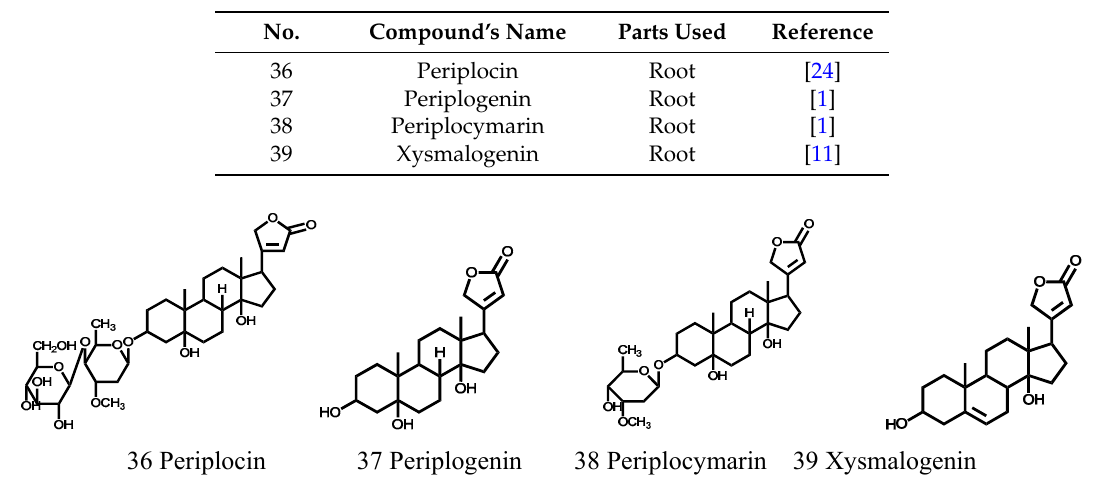
Table 2. Cardiac glycosides from Cortex Periplocae (36–39).